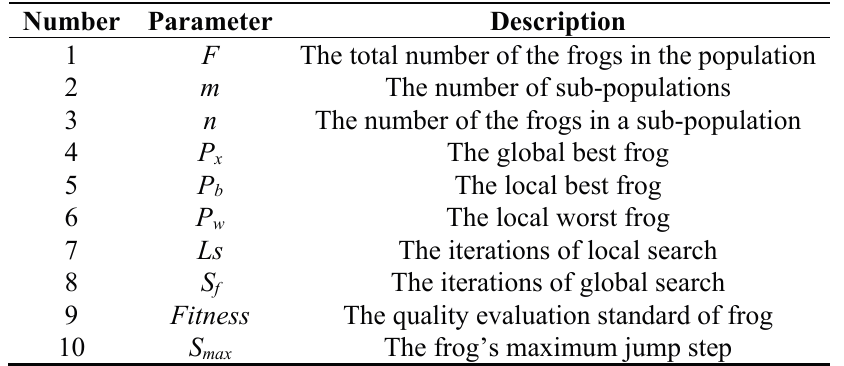
Figure 1. Flow chart of shuffled frog leaping algorithm. Table 1. The parameters of Shuffled Frog Leaping Algorithm